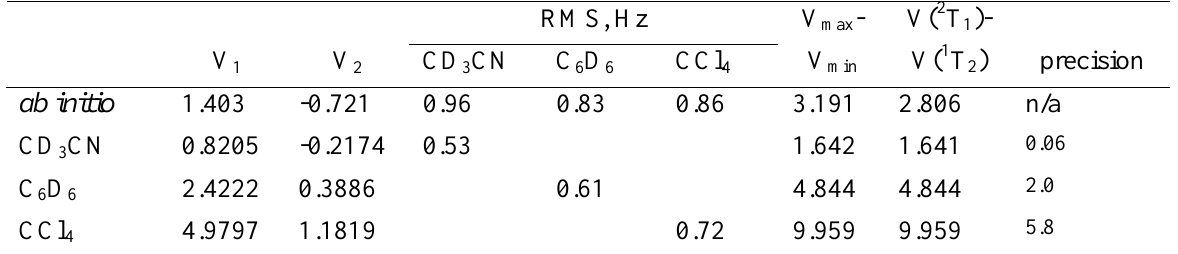
Table 6. Results of pseudorotational potential optimization for trans-1,2-dibromocyclopentane.